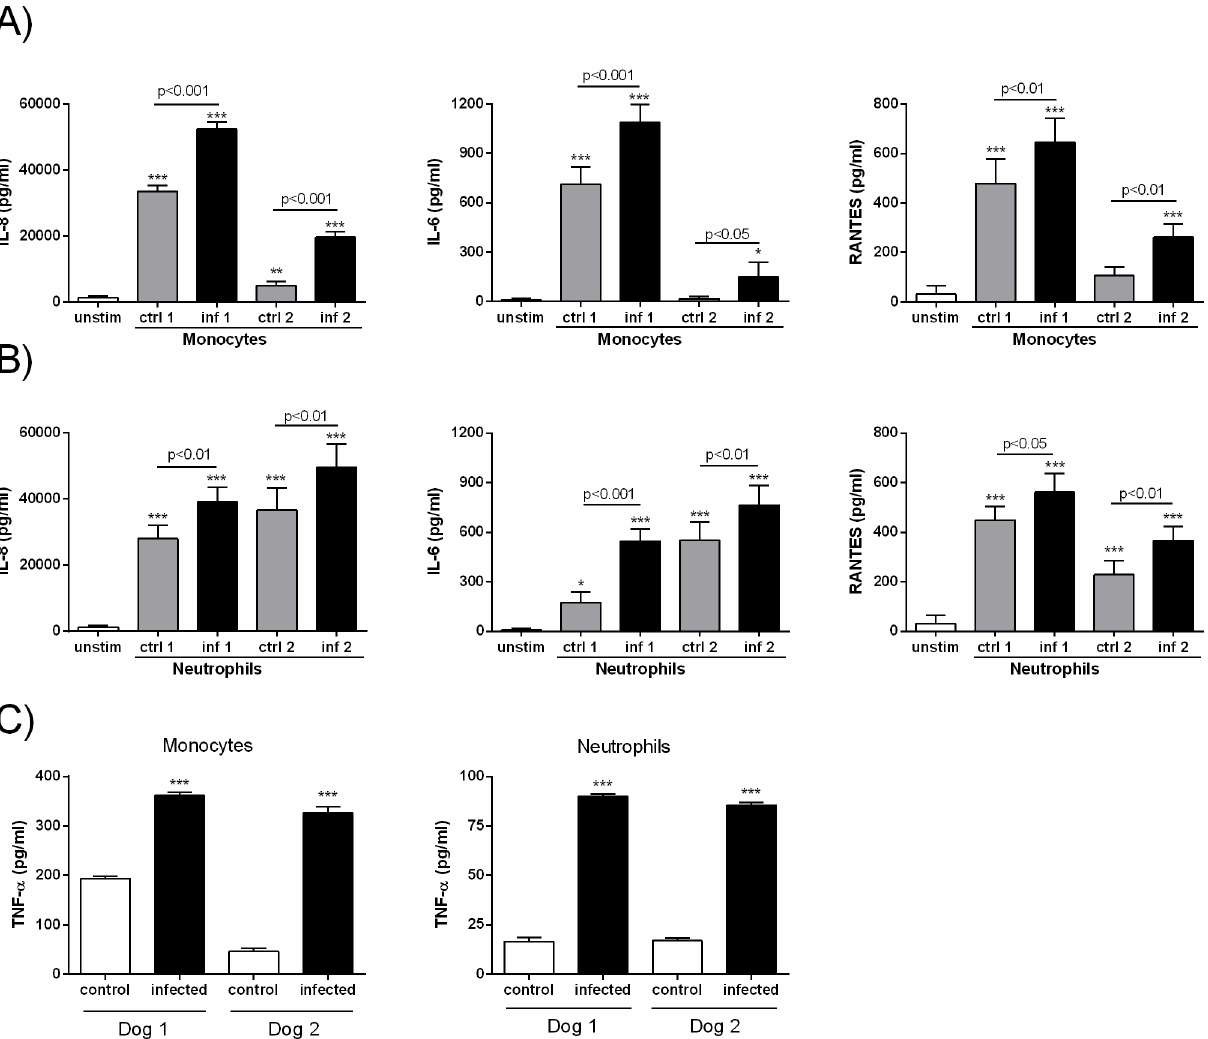
Fig 3. Canine trophoblasts secreteproinflammatory chemokines and cytokines in response to stimulation with conditioned media (CM) from B . canis -infected monocytes and neutrophils. Trophoblasts isolatedfrom 12 term placentaswere stimulatedfor 24 h with 1/5 dilutionsof the CM. Unstimulatedtrophoblasts culturedunder the same conditions served as controls. Levels of IL-8, IL-6 and RANTES (CCL5) were measuredin culture supernatants of trophoblasts stimulated with CM from monocytes(A) or neutrophils(B). Values are means ± SD of duplicatemeasurements from three independentexperiments. Asterisks over bars indicatesignificantdifferencesas compared to unstimulated trophoblasts ( * p < 0.05; ** p < 0.01; *** p < 0.001,ANOVA followedby Tukey ᾿ s test). C) TNF- α secretionby B . canis -infected canine monocytes and neutrophils. The cells were purifiedfrom peripheral bloodof 4 healthy dogs, and were infected in vitro with B . canis (MOI 100). TNF- α was measuredin culture supernatants at 24 h p.i. Values are means ± SEM of triplicate measurements. Asterisks indicate significantdifferences as comparedto uninfected(control) cells ( *** p < 0.001,Student ᾽ s t test).